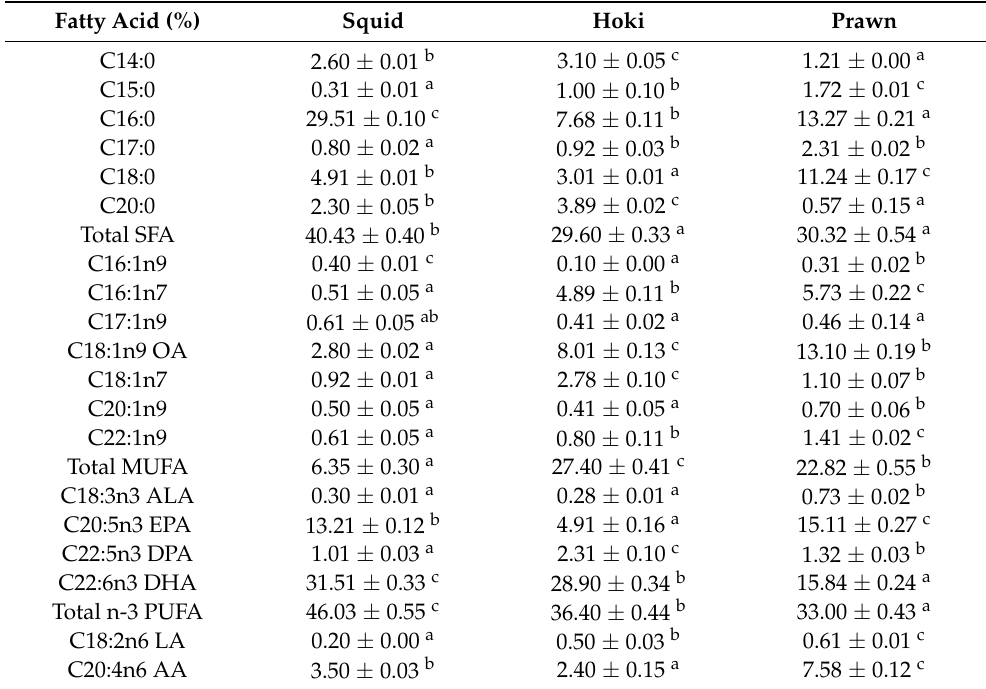
Table 1. Fatty acid compositions of lipids from hoki, squid and prawn. Fatty Acid (%) Squid Hoki Prawn